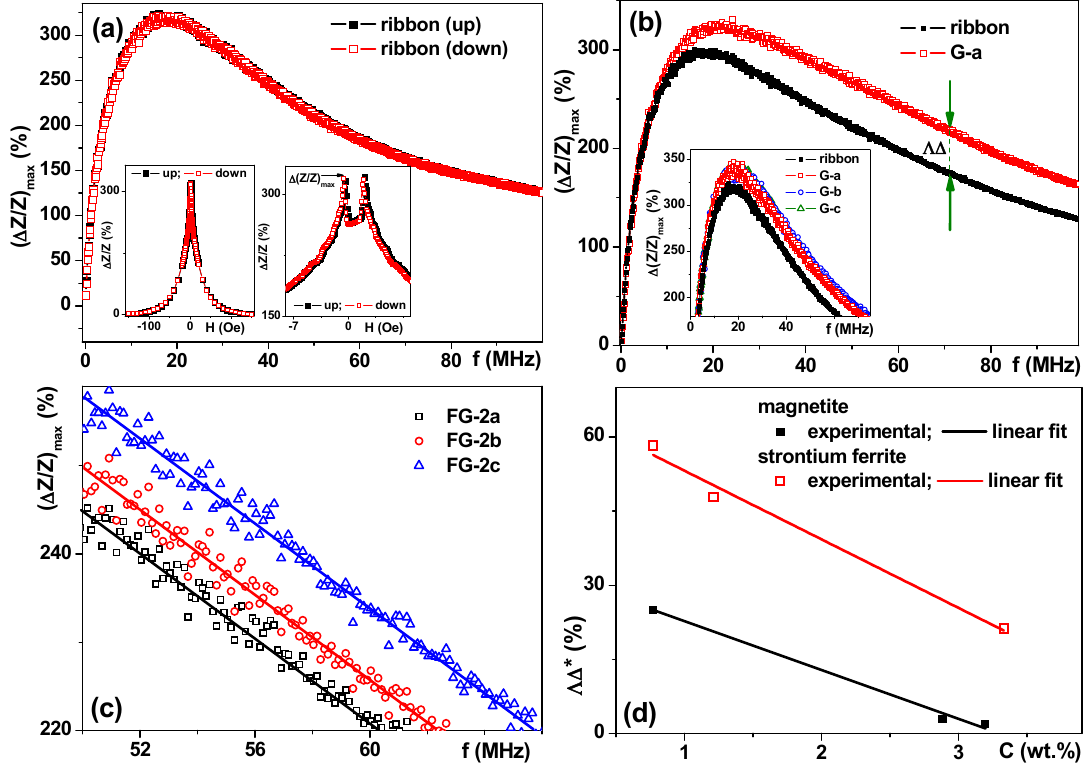
Figure 12. Frequency dependence of ( Δ Z/Z ) max ratio for Co 68.6 Fe 3.9 Mo 3.0 Si 12.0 B 12.5 rapidly quenched amorphous ribbon. Insets show field dependence of Δ ( Z/Z ) ratio for 15 MHz frequency: left inset–is given for large field interval and right inset is given for low magnetic fields ( a ). Frequency dependence of ( Δ Z/Z ) max ratio for amorphous ribbon without and with G-a gel. Green arrows explain definition of Λ Δ parameter. Inset shows better resolution image for ( Δ Z/Z ) max ratio for amorphous ribbon without and with G-a, G-b and G-c gels ( b ). Selected region of frequency dependence of ( Δ Z/Z ) max ratio for amorphous ribbon with FG-2 ferrogels, the thickener was xanthan gum ( c ). Concentration dependence of the Λ Δ * = Λ Δ (gel)– Λ Δ (ferrogel) difference for FG-2 and FG-4 ferrogels for frequency f = 60 MHz ( d ).